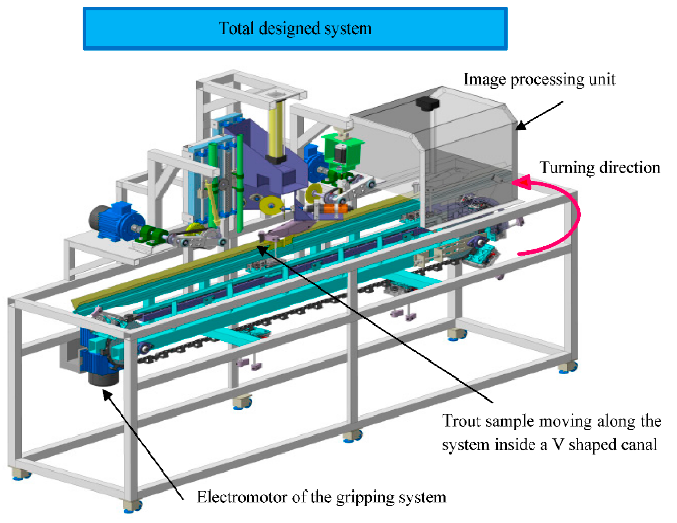
Figure 5. The complete design of the trout-processing machine.